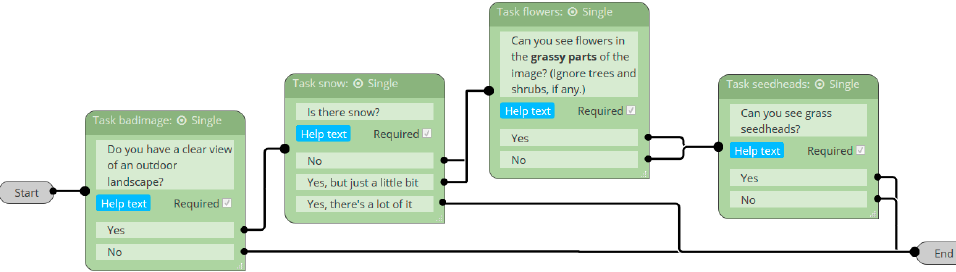
Figure 3. Workflow for PhenoCam images containing grass. See Supplementary Materials Figure S1 for all other workflows.